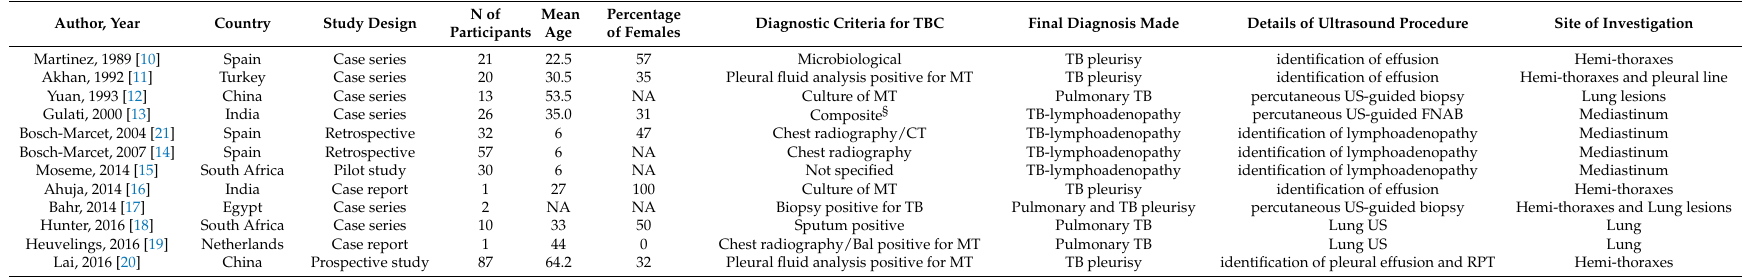
Table 1. Descriptive characteristics of the study participants, study design, and chest ultrasound (CUS) techniques